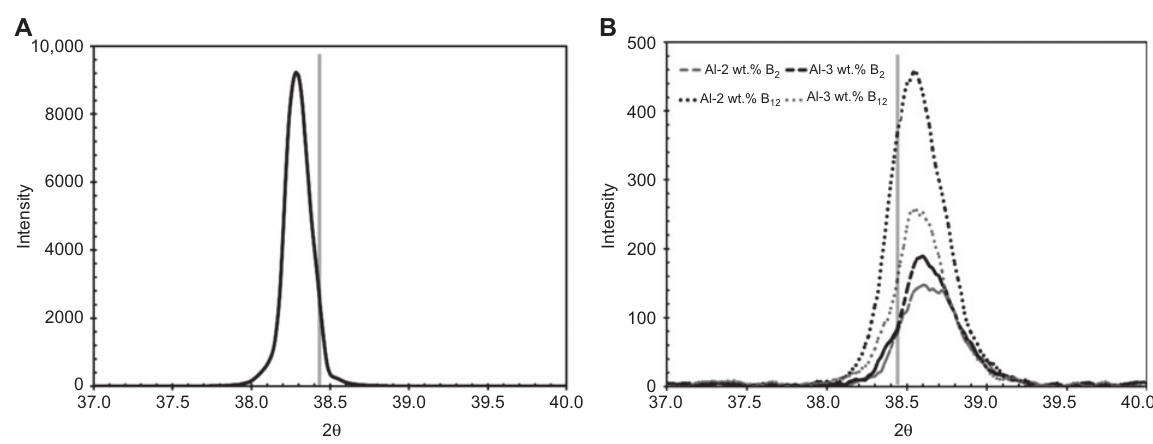
Figure 7 Diffraction patterns of fi lms deposited over silicon substrates: (A) from aluminum target; (B) from centrifuged targets.